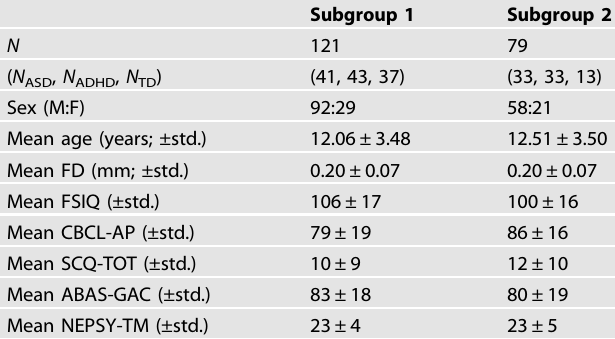
Table 6. Participant demographics and descriptive statistics for the clinical behavioural measures for the data-driven